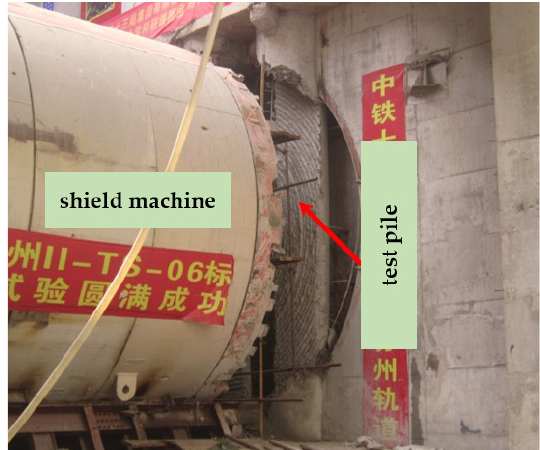
Figure 8. Photo of the field test site.